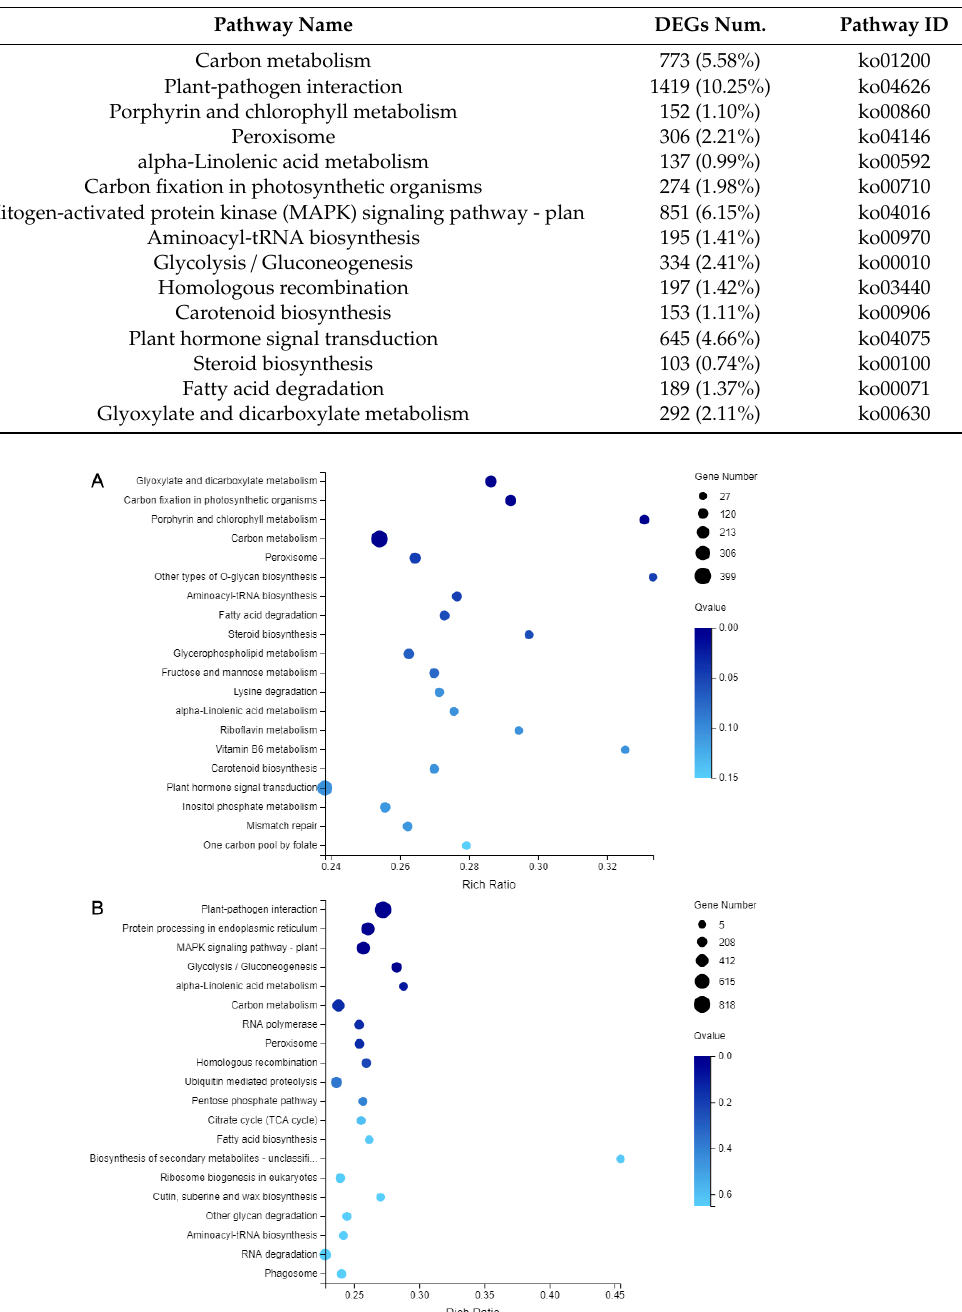
Table 2. Kyoto encyclopedia of genes and genomes (KEGG) pathways with pathway identity information.